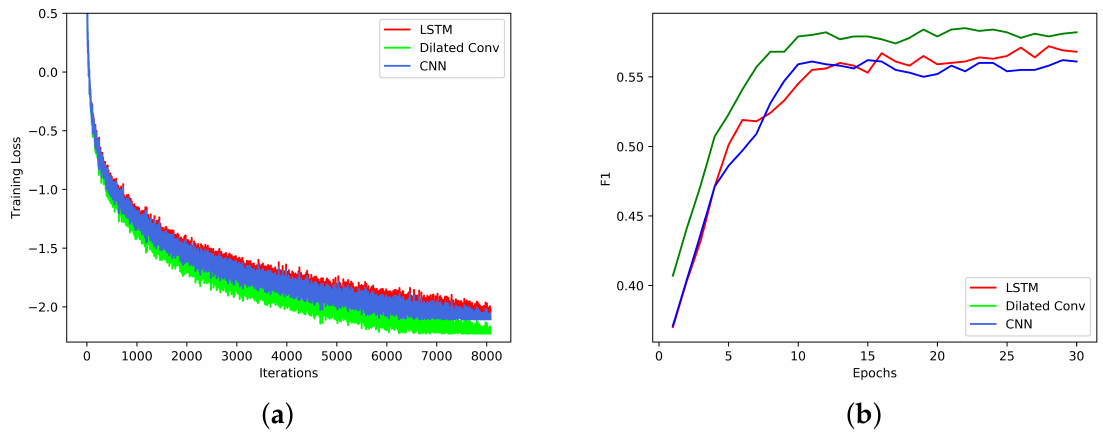
Figure 8. Comparison of results of our model based on different neural units on the WebNLG dataset. ( a ) Loss curves of our model based on different neurals units; ( b ) The value of F1 in each epoch of our model based on different neurals units.